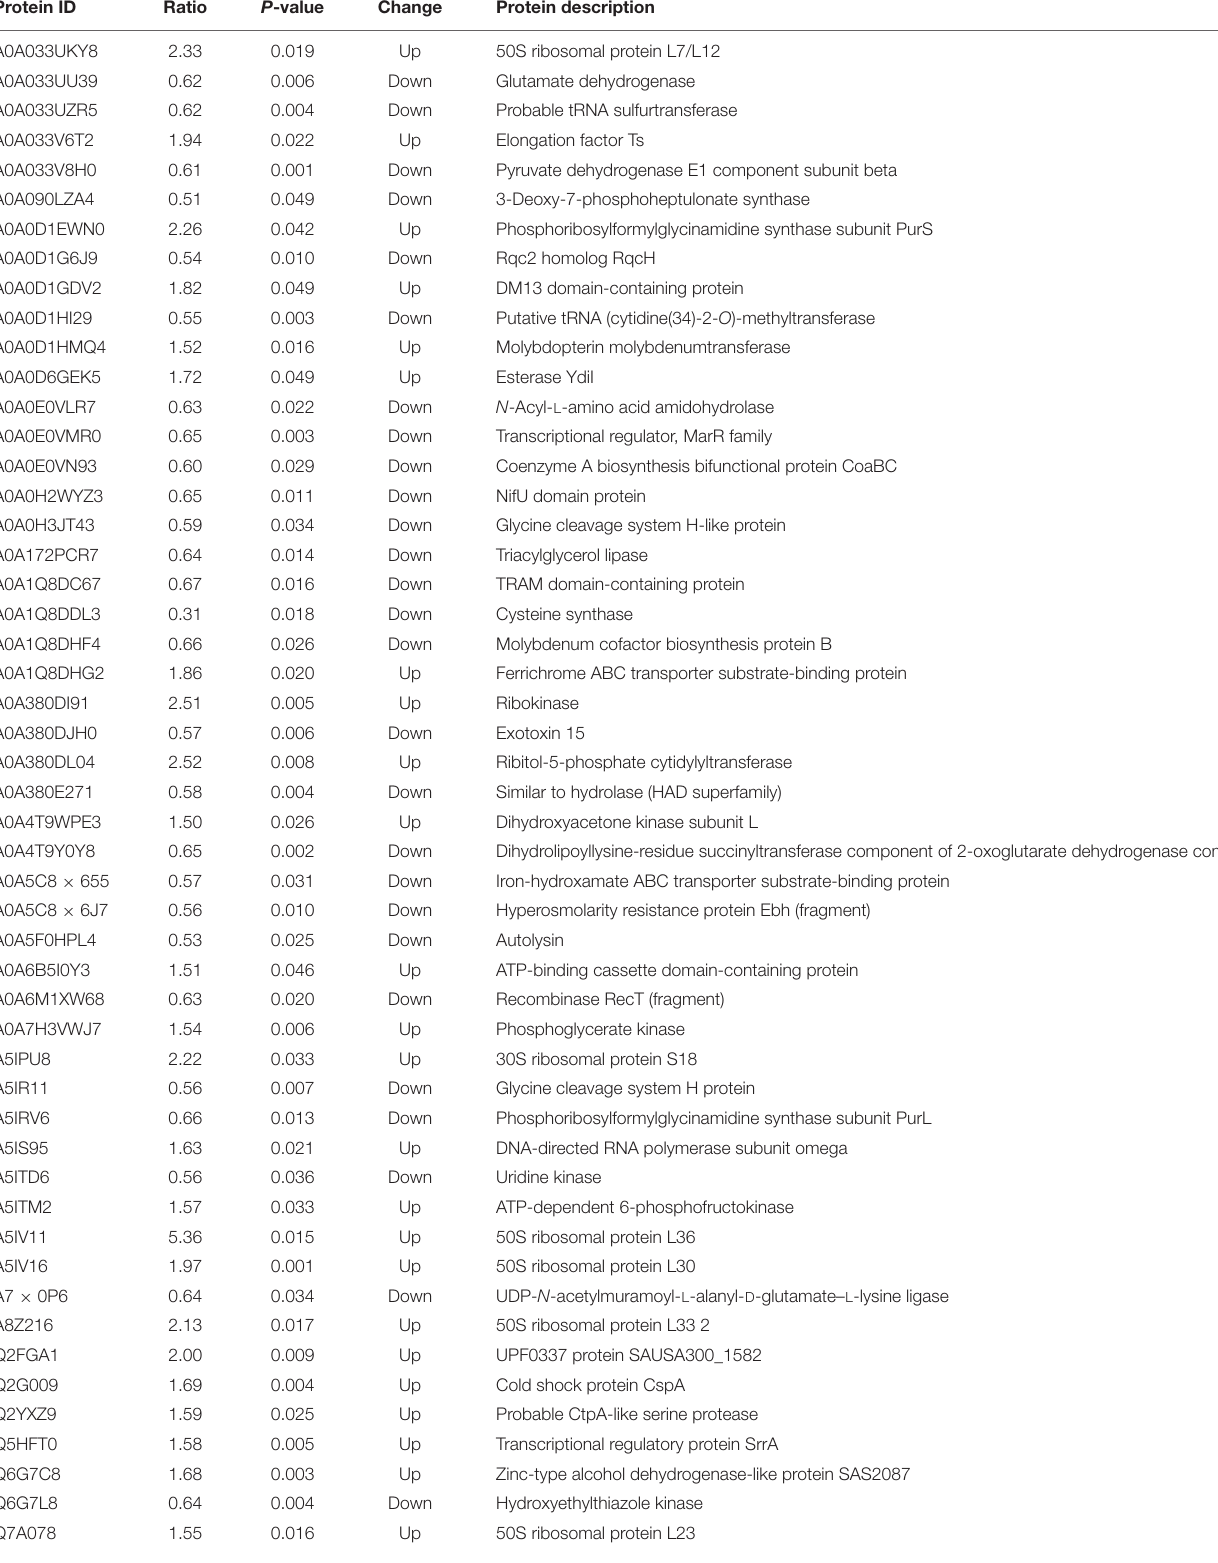
TABLE 3 | Some bacterial response-related DEPs of S. aureus after 1/2-OEO treatment. Protein ID Ratio P